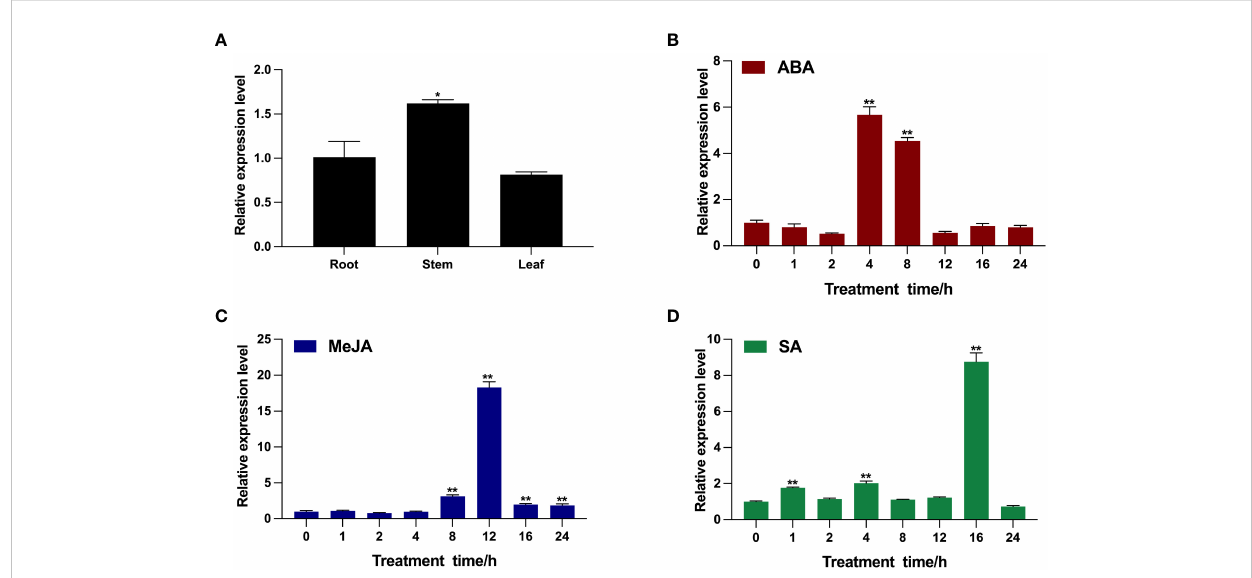
FIGURE 3 Transcription pattern of BcTSA in different B . cusia tissues (A) and under the induction of phytohormones (ABA (B) , MeJA (C) , and SA (D) ) by RT- qPCR analysis. Data are represented as the mean ± SEM; * P < 0.05 and, ** P < 0.01 compared to the control group. All reactions were carried out in triplicate, and each experiment was repeated